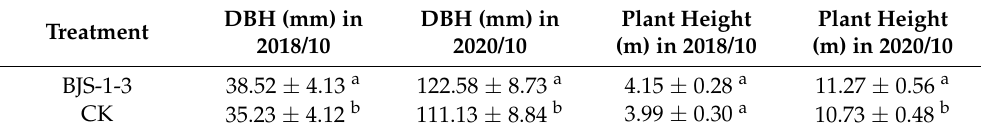
Table 1. DBH and plant height changes in poplar trees.